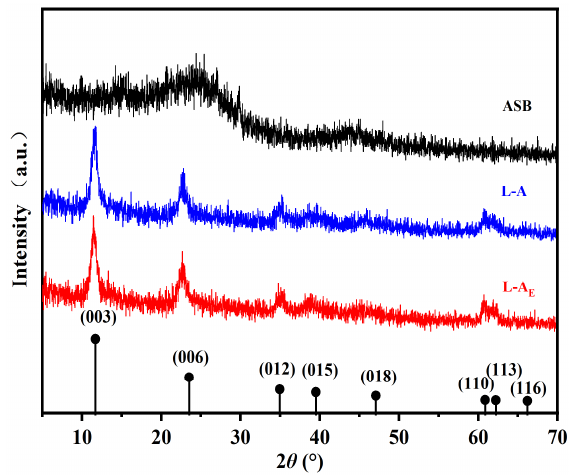
Figure 3. XRD patterns of the materials.